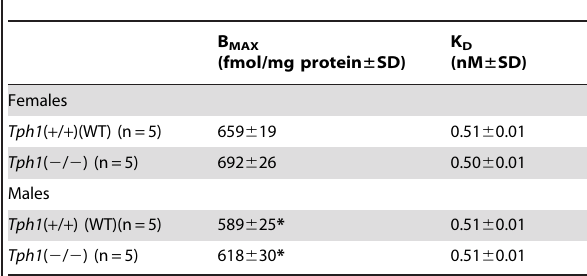
Table 2. SERT Binding Parameters in Mouse